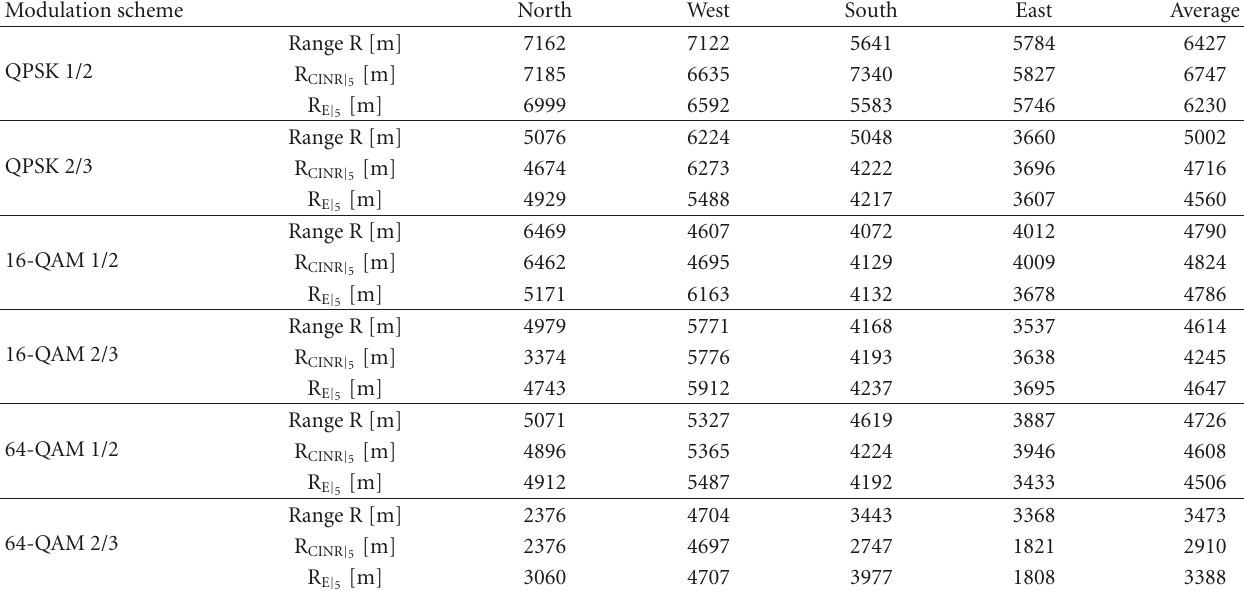
, and R E | for the di ff erent modulation schemes and the di ff erent 5 5